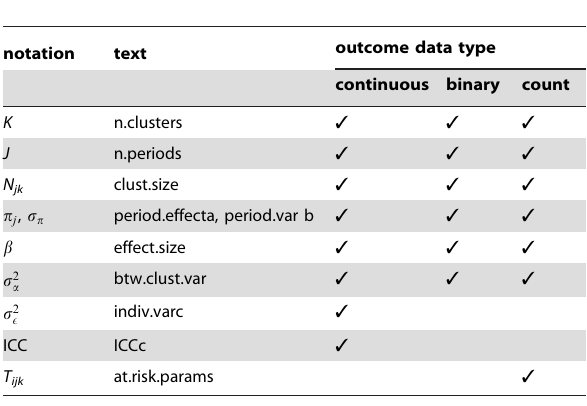
Table 1. Parameters from data generating models needed to simulate